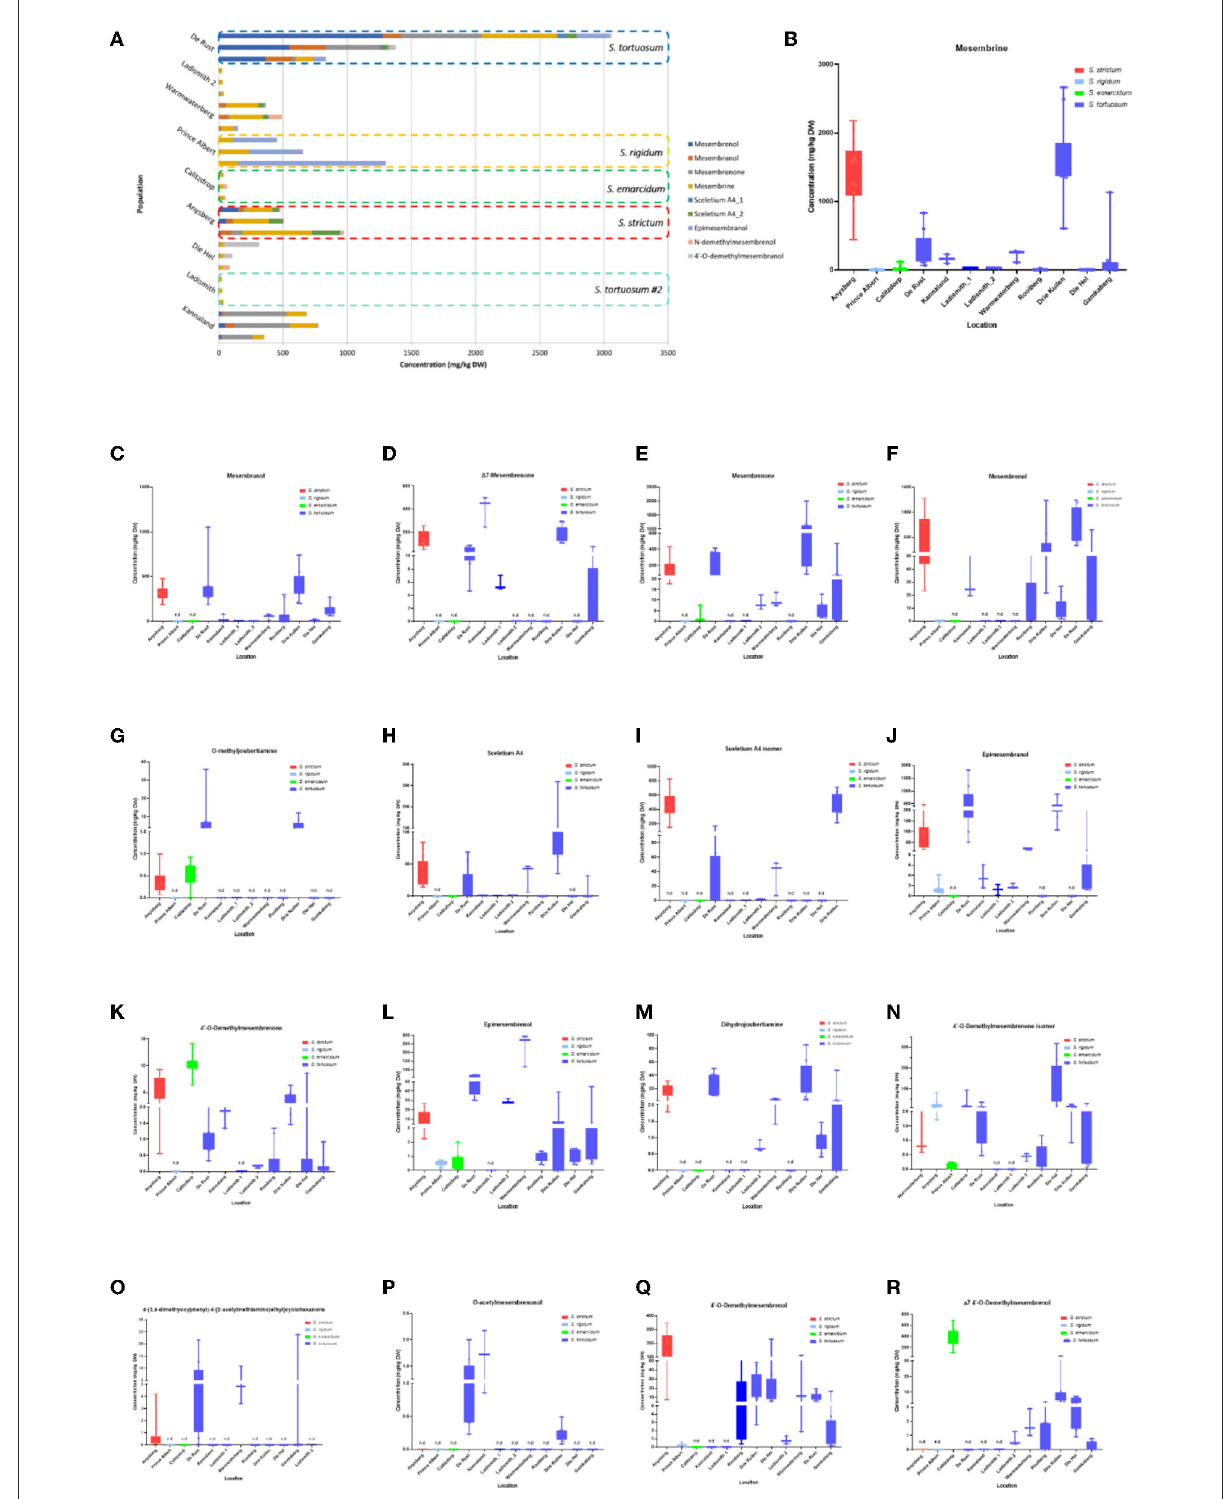
FIGURE5 (A) Concentration of Sceletium metabolites in different species and populations found at twelve locations. Horizontal stacked columns represent metabolites (mg/kg DW) tentatively identified chemical markers responsible for metabolomic separations. Each horizontal stacked column represents up to 10 individuals per location and/or taxon S. tortuosum B-R) Concentration of tentatively identified metabolites (mg/kg